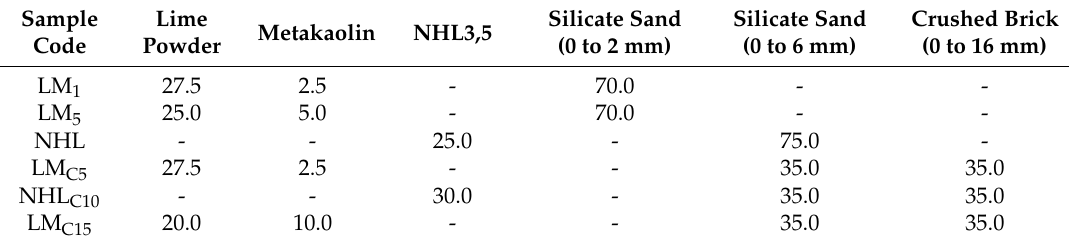
Table 6. Synthesis of selected restoration mortars [59,60].